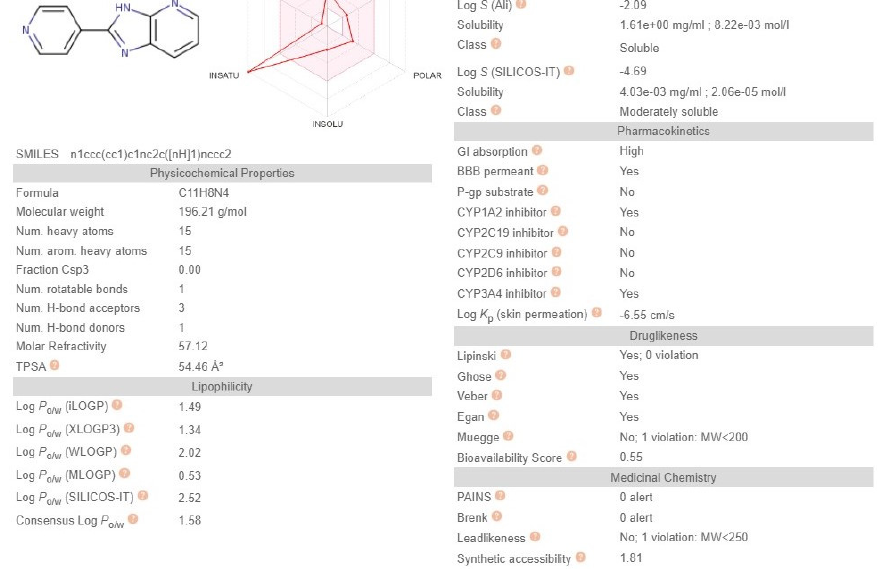
Figure 9. ADME for L2 .